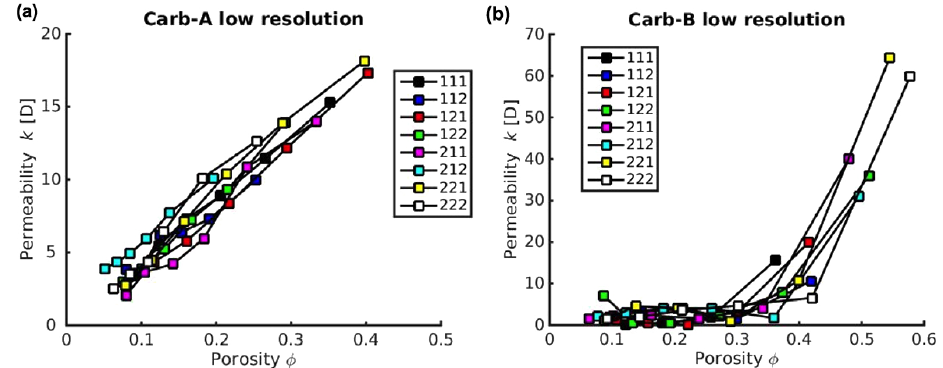
Figure 9. Simulated intrinsic permeability as a function of porosity. Results for the eight subvolumes of Carb-A (left-hand side) and Carb-B (right-hand side) low-resolution samples. Squares markers display each of the pore–solid configurations.